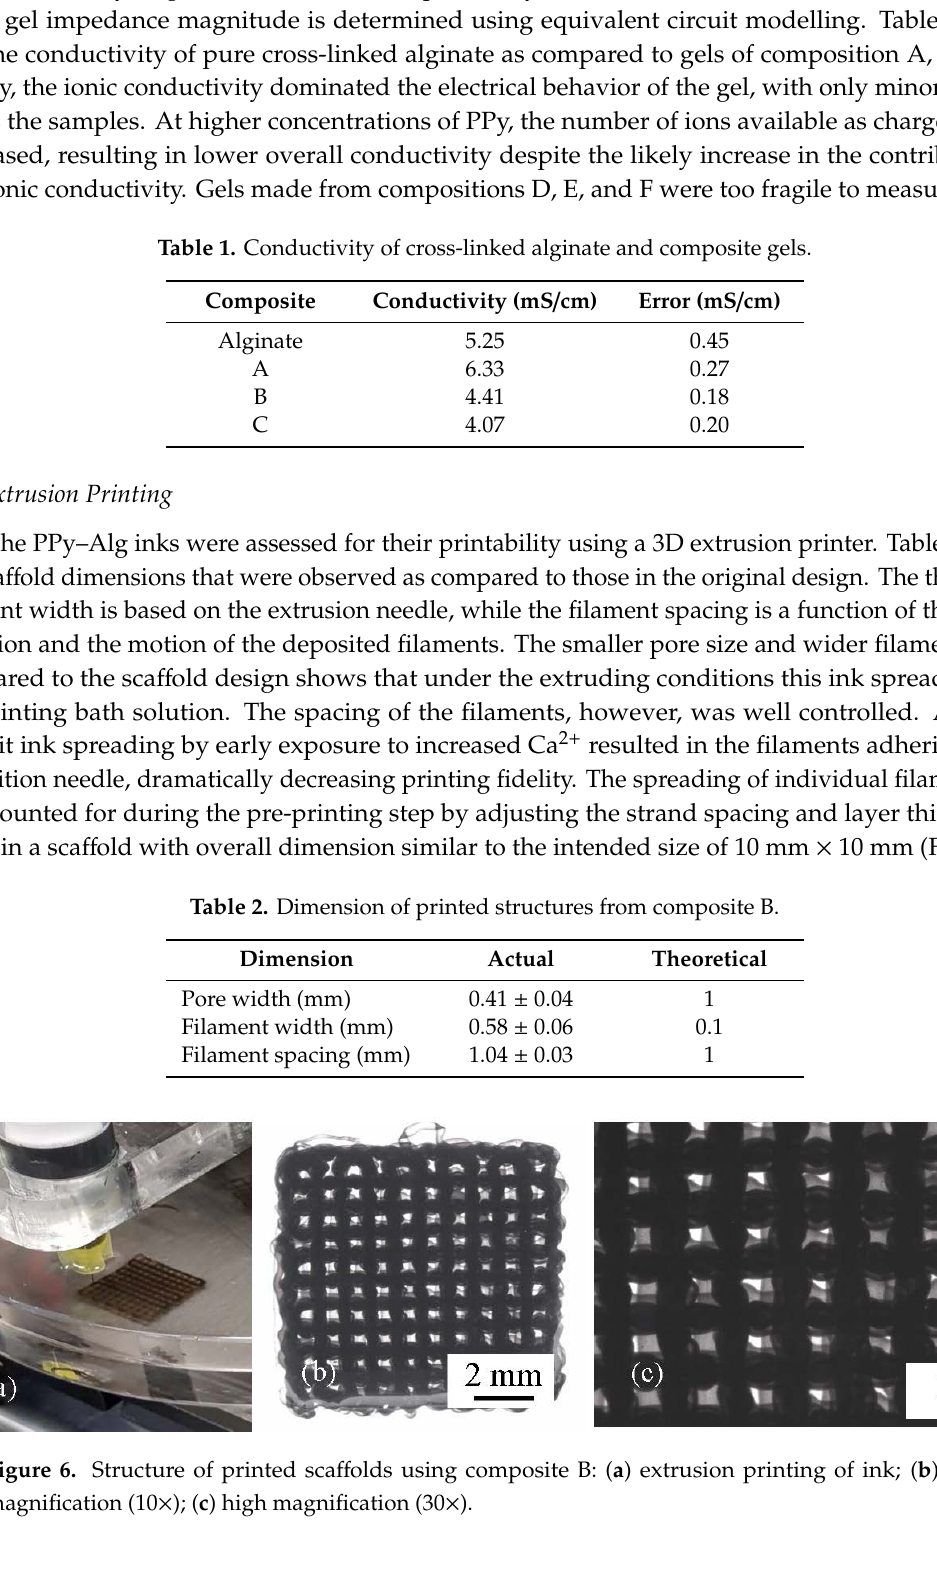
Figure 5. Conductivity of non-cross-linked (black) and cross-linked (grey) PPy–Alg thin films of composition A, B, C, and D measured via the four-point probe method.